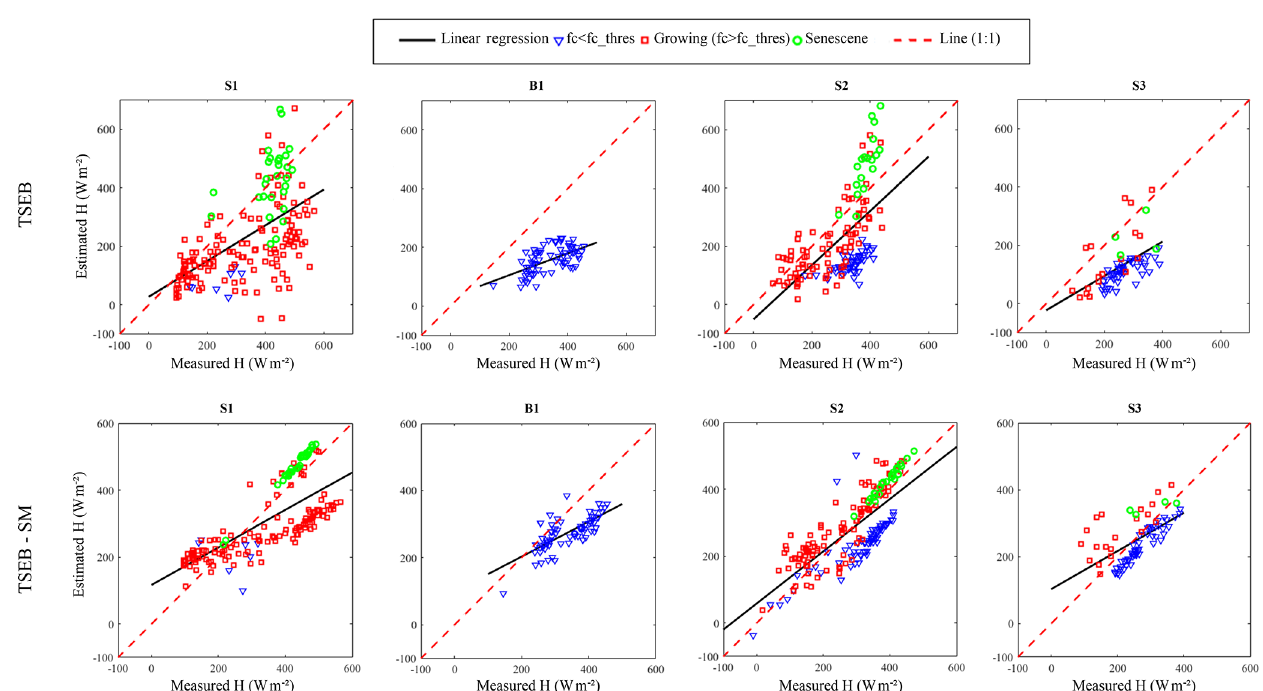
Figure 10. Same as Fig. 8 but for satellite data.